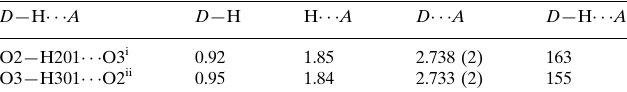
Hydrogen-bond geometry (A˚ , (cid:2)